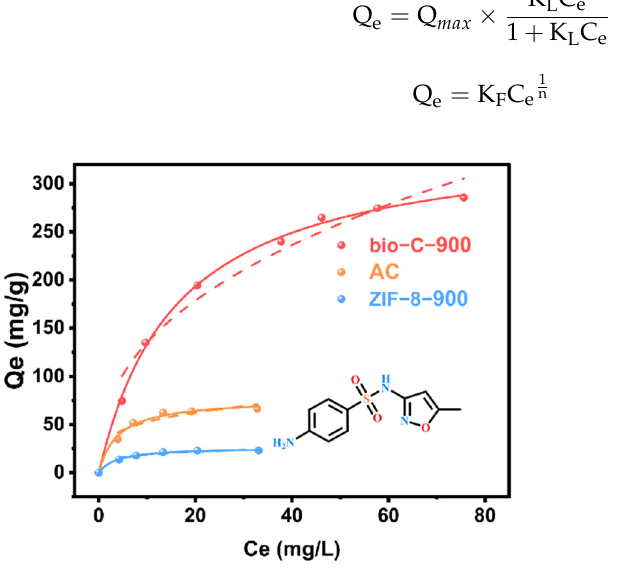
Figure 7. Adsorption isotherm for the removal of SMX over the three materials: active carbon (AC), ZIF − 8 − C, and bio − C − 900. Reaction conditions: initial concentration of SMX = 5~80 mg/L, initial solution pH = 7, temperature = 25 ◦ C, reaction time = 600